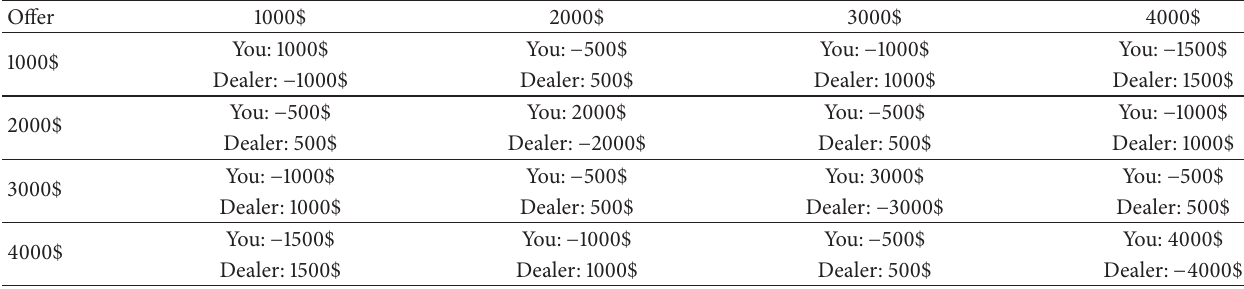
Table 5: Payoff matrix of The Price is Right.